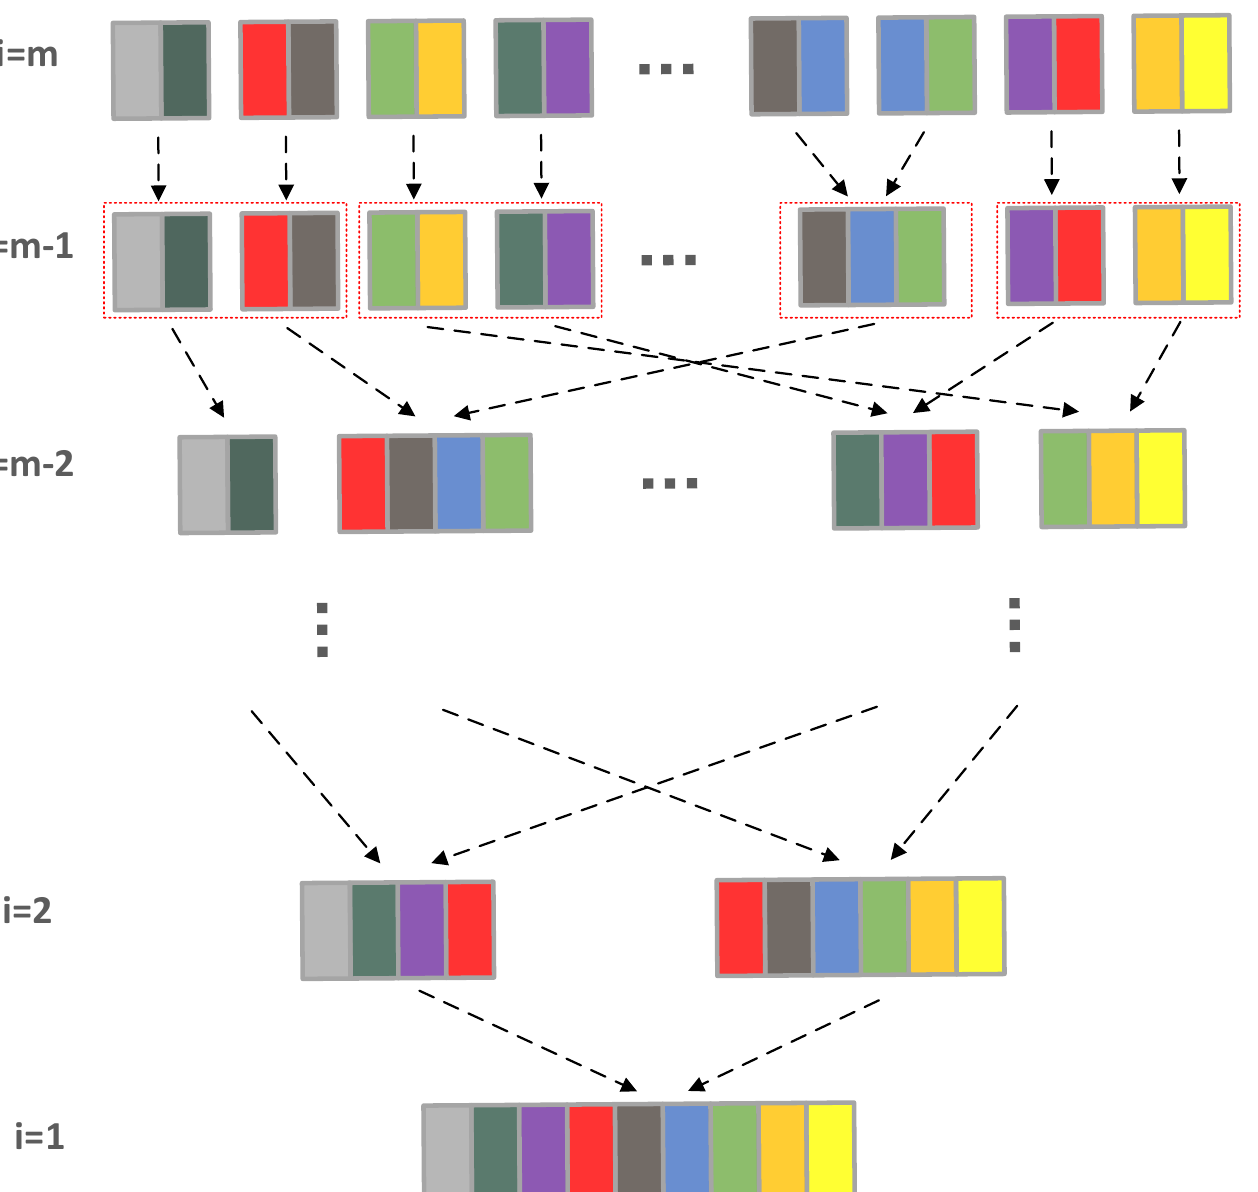
Figure 2. Image mosaic structure diagram of merge sorting. The m -th layer represents the input unordered images, and the first layer represents the final stitched image. The parts with the same colors represent the overlapping areas of the images.